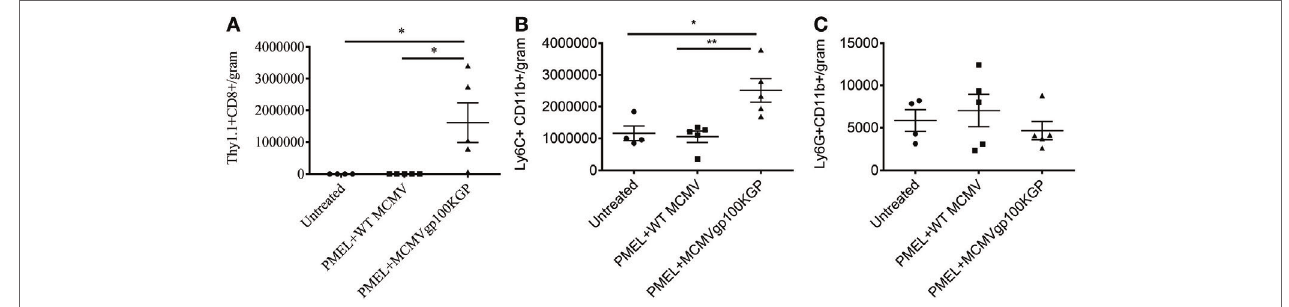
FigUre 7 | MCMVgp100KGP vaccination induces accumulation of Ly6C + myeloid cells. Mice bearing B16F10 tumors were treated left untreated, treated with PMEL transfer i.v. and 10 5 PFU wild-type (WT) MCMV i.p., or treated with PMEL transfer i.v. and 10 5 PFU MCMVgp100KGP i.p. Six days later, tumor tissue was harvested for flow cytometry. Graphs show cell counts per gram tumor tissue for (a) Thy1.1 + CD8 + PMEL cells, (B) Ly6C + CD11b + cells, and (c) Ly6G + CD11b + cells. * p < 0.05; ** p < 0.01; n = 4–5 mice/group. Data are representative of two independent